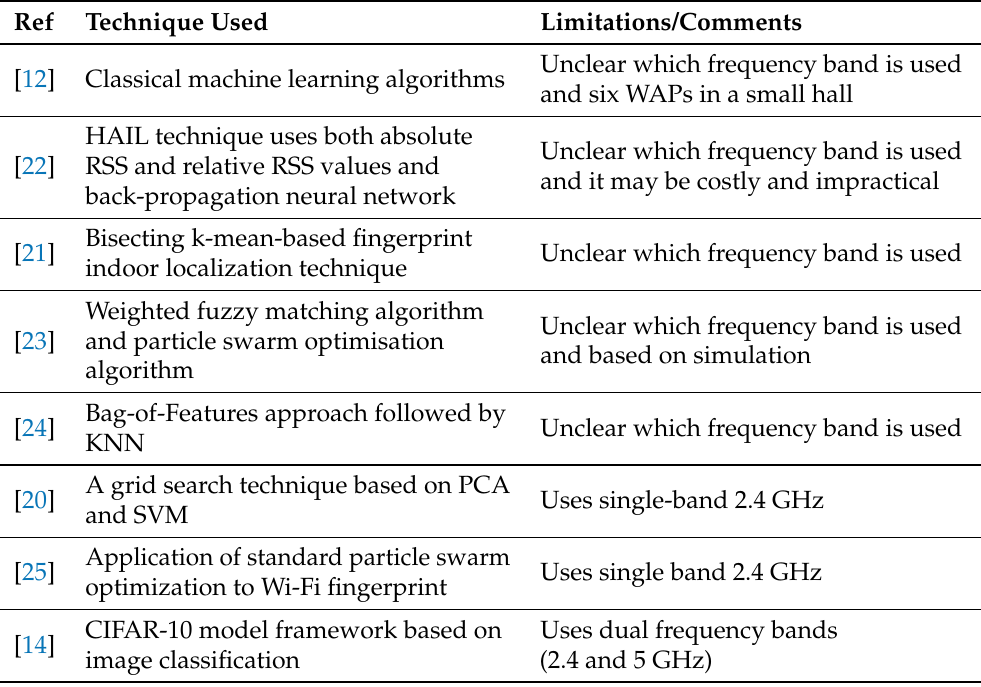
Table 1. Comparison of similar